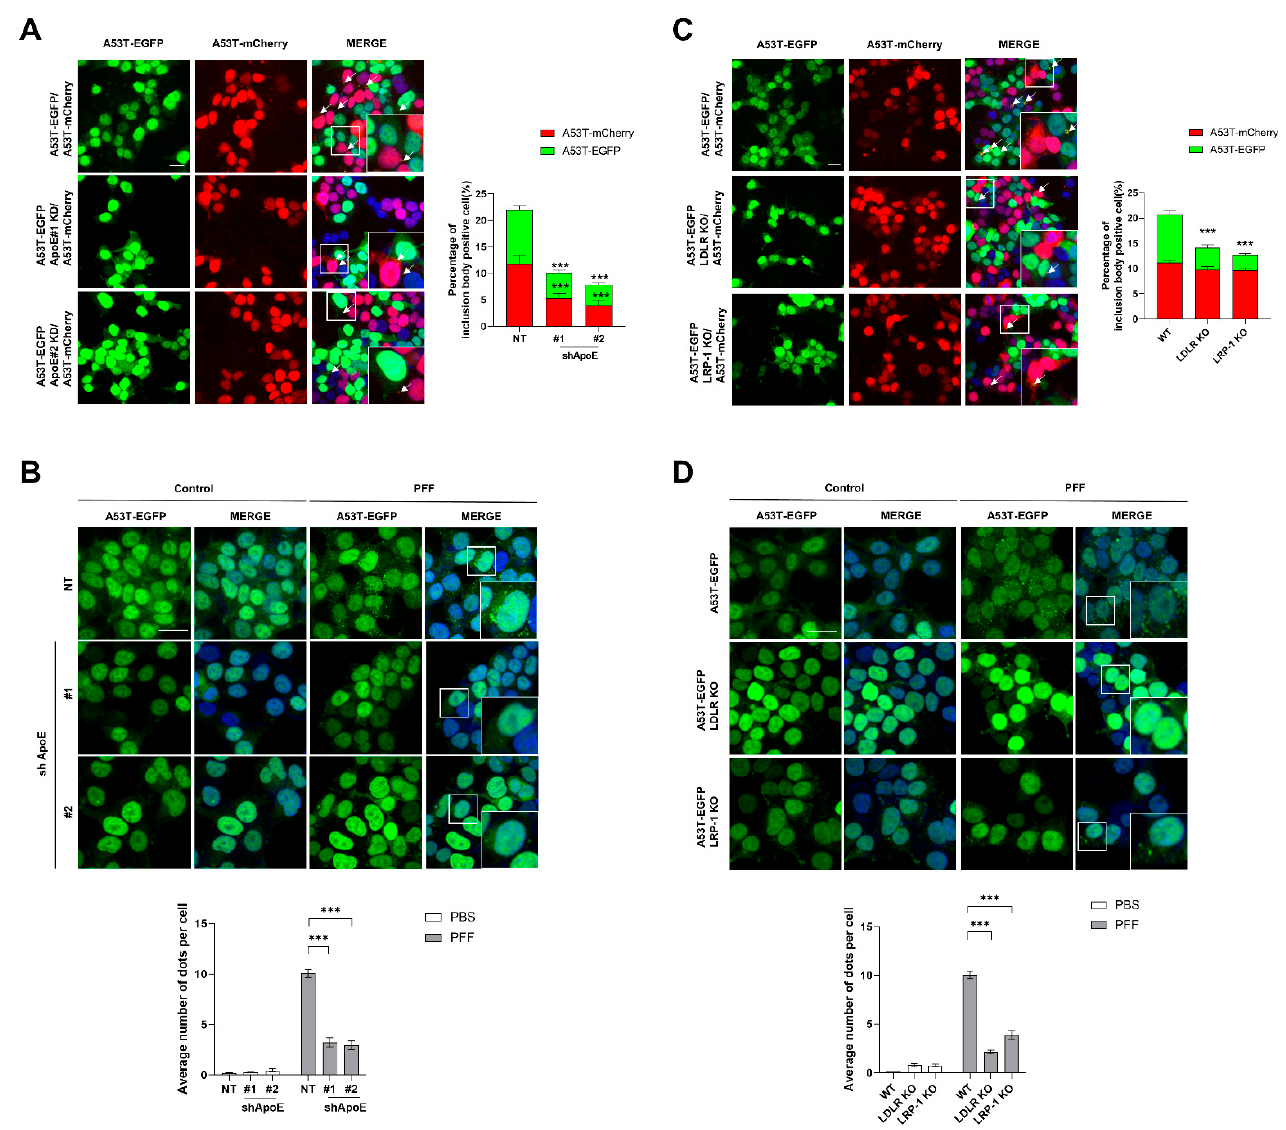
Figure 4. ApoE deficiency inhibits α -syn propagation. ( A ) NT and ApoE KD #1, #2/A53T α -syn- EGFP OE SH-SY5Y cells were cocultured with A53T α -syn-mCherry OE SH-SY5Y cells for 5 days in the presence of 50 μ M RA. The samples were then observed under a confocal microscope, and the number of cells containing double fluorescence-labeled puncta was analyzed. Values were derived from three independent experiments ( n = 3). ( B ) After the treatment of NT and ApoE KD #1, #2/A53T α -syn-EGFP OE SH-SY5Y cells with 1 μ M α -syn fibrils for 24 h, the cells were fixed, the samples were analyzed by confocal microscopy, and the number of aggregated puncta was counted with MetaMorph software. Nuclear images based on DAPI were precluded. Values were derived from three independent experiments ( n = 3). ( C ) NT and LDLR KO, LRP-1 KO/A53T α -syn-EGFP OE SH- SY5Y cells were cocultured with A53T α -syn-mCherry OE SH-SY5Y cells for 5 days in the presence of 50 μ M RA. Then, the samples were observed under a confocal microscope, and the number of cells containing double fluorescence-labeled puncta was analyzed. Values were derived from three independent experiments ( n = 3). ( D ) After the treatment of NT and LDLR KO, LRP-1 KO/A53T α - syn-EGFP OE SH-SY5Y cells with 1 μ M α -syn fibril for 24 h, the cells were fixed. The samples were then analyzed by confocal microscopy and the number of aggregated puncta was counted with MetaMorph software. Values were derived from three independent experiments ( n = 3). *** p < 0.001 against the control; one-way ANOVA. Blue indicates DAPI staining. Scale bars indicate 20 μ m.